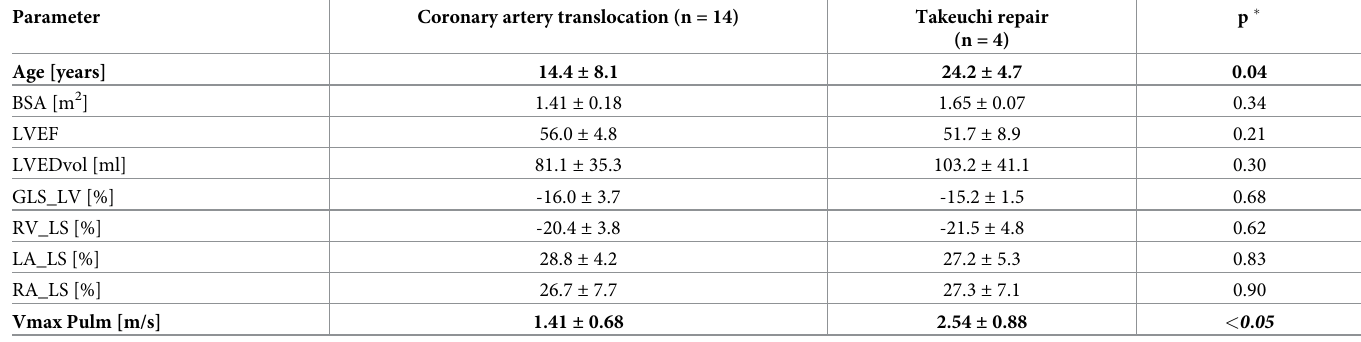
For abbreviations see Table 4; Vmax Pulm–maximal pulmonary artery systolic velocity � Student’s t test for independent samples or Mann Whitney U test